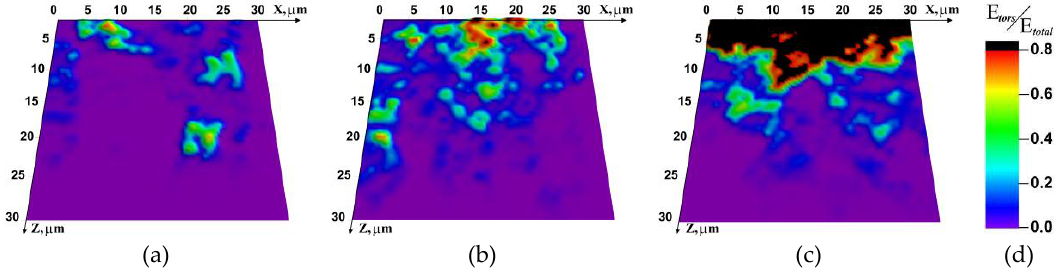
(d) Figure 6. Specific rotation energy distribution on specimen faces at different temperatures at 500 μs after the beginning of loading. ( a ) −60 °C; ( b ) −20 °C; ( c ) 20 °C; ( d ) color legend. In our opinion, the localized change of the specific rotation energy only in the upper layers of the cellular automaton is first of all associated with the account for the grain structure of the studied mesoscopic volume in the model. The relaxation of stresses arising under localized high-rate load applied from the upper face occurs mostly due to deformation in the upper layer of the mesoscopic volume. The effect of test temperature on the observed difference agrees well with the above analysis of elastic deformation characteristics. Figure 7 shows the distribution of the relative rotation energy. The distribution remains almost unchanged with time at the lowest test temperature ( T = −60 °C), even despite the change in the direction of applied external load. As relaxation becomes more probable with the growing temperature ( T = −20 °C), the size of the region involved in inelastic deformation increases, including the distribution in Z direction (Figure 7b). At room temperature (Figure 7c), inelastic deformation revealed from the rotation energy distribution is mostly localized in the upper layer, again apparently due to the activation of dissipation at the boundaries of structural elements (grains). This assumption is convincingly supported by the variation curves of the average magnitude of local angular velocity shown in Figure 4. This parameter is seen to increase proportionally to the test temperature and achieves its maximum value when the direction of applied load is changed ( t = 500 μs), for all test temperatures. On the other hand, the minimum value of this parameter is observed at t = 750–800 μs (then it increases again, probably due to the oscillating character of elastic energy accumulation and its subsequent release at the structural element boundaries). This fact was confirmed by analyzing the distribution of accumulated relative rotation energy at test room temperature (Figure 7c). It was found that at t = 750 sec the distribution pattern of the analyzed quantity is nearly the same as the pattern at t = 500 μs, despite the fact that the applied load direction changed. On the other hand, at the lowest test temperature T = −60 °C for the same loading